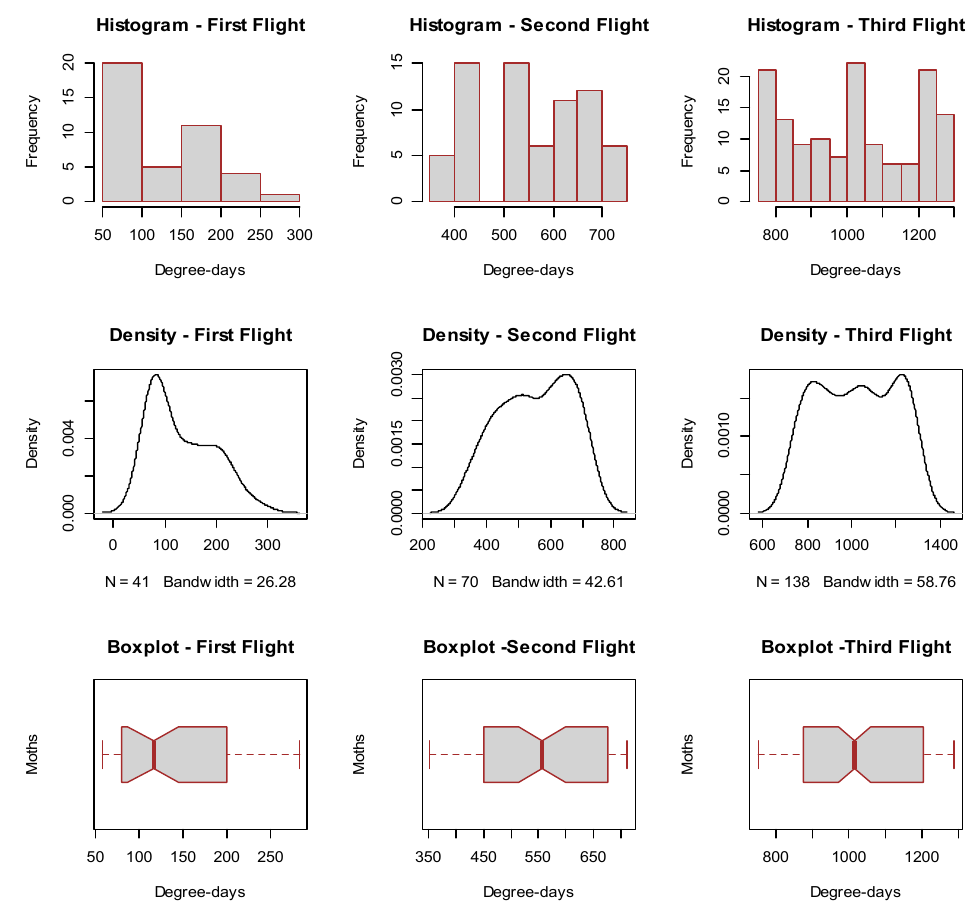
Figure 2. Description of moth capture data distribution frequencies, densities and empirical quartiles for the first, second and third flight of H. armigera moths in respect to accumulated degree-days > 10.1 °C after 1 January 2021.